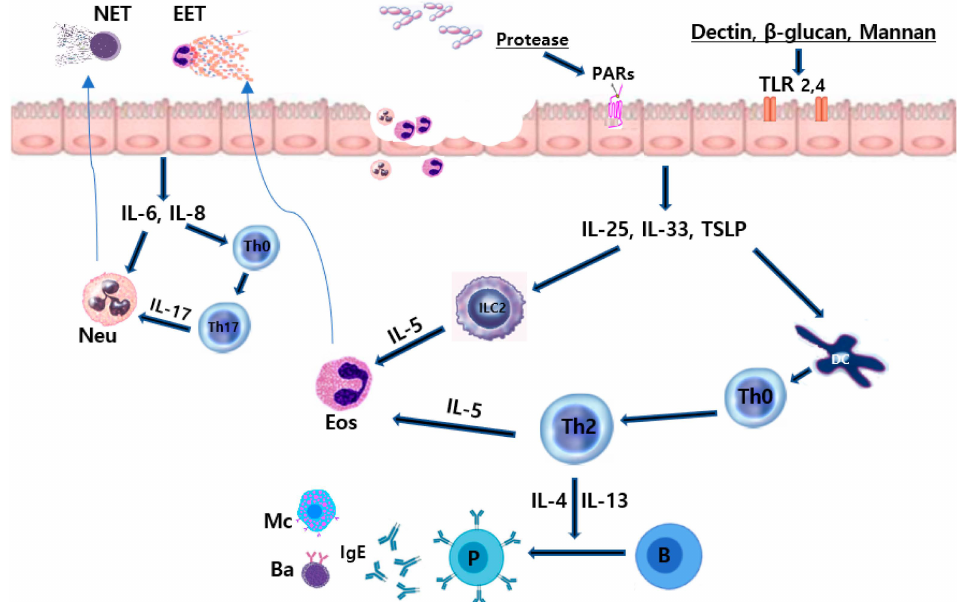
Figure 1. Immunopathologic effects of fungi on the sinonasal mucosa. Fungal proteases and components interact with epithelial cell receptors and release innate inflammatory cytokines. Fungi can induce eosinophilic and neutrophilic inflammation in sinonasal mucosa. IL, interleukin; TSLP, thymic stromal lymphopoietin; IgE, immunoglobulin E; Th, T helper cell; B, B cells; P, plasma cells, Ba, basophils;